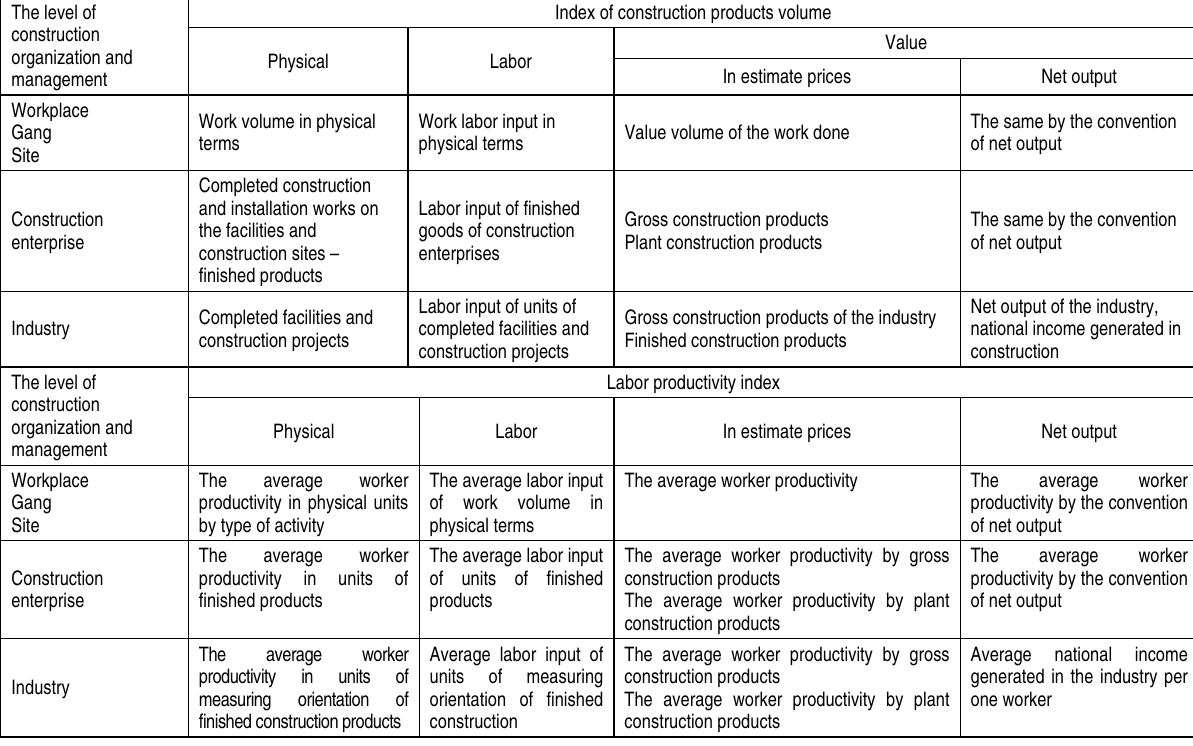
Table 1. The indices system of construction products and labor